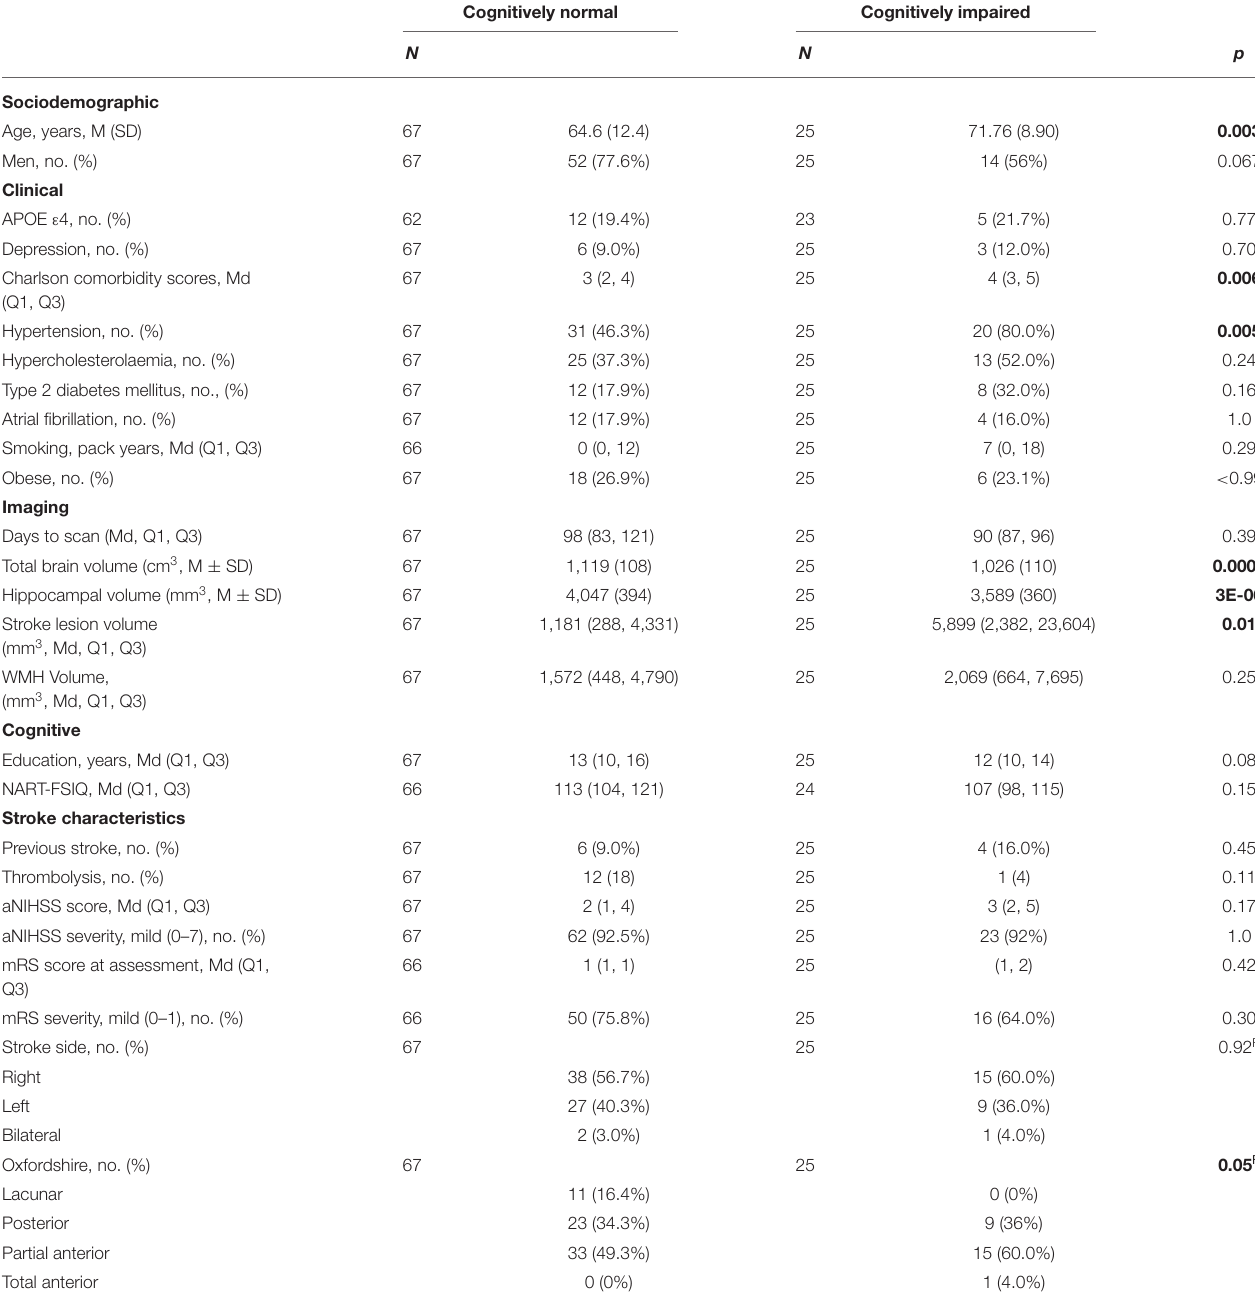
TABLE 3 | Characteristics of stroke participants who were cognitively normal vs. cognitively impaired at 3-month visit. Cognitively normal Cognitively impaired N N